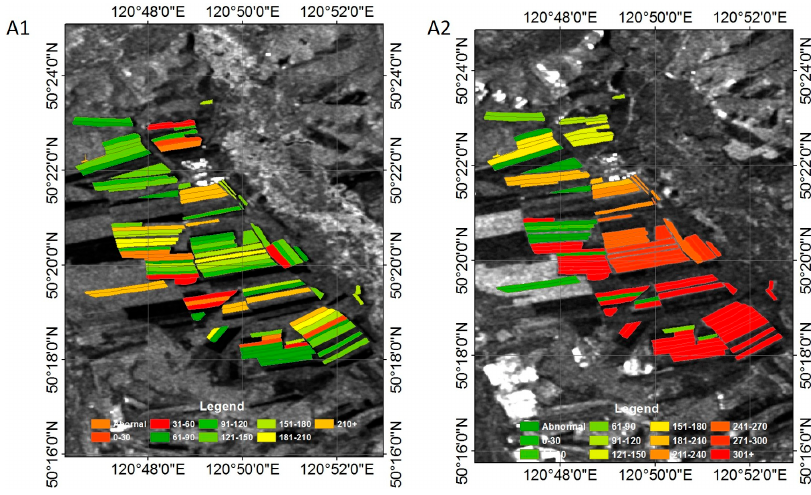
Figure 6. A comparison of estimation errors between two models at each stage is shown in Table